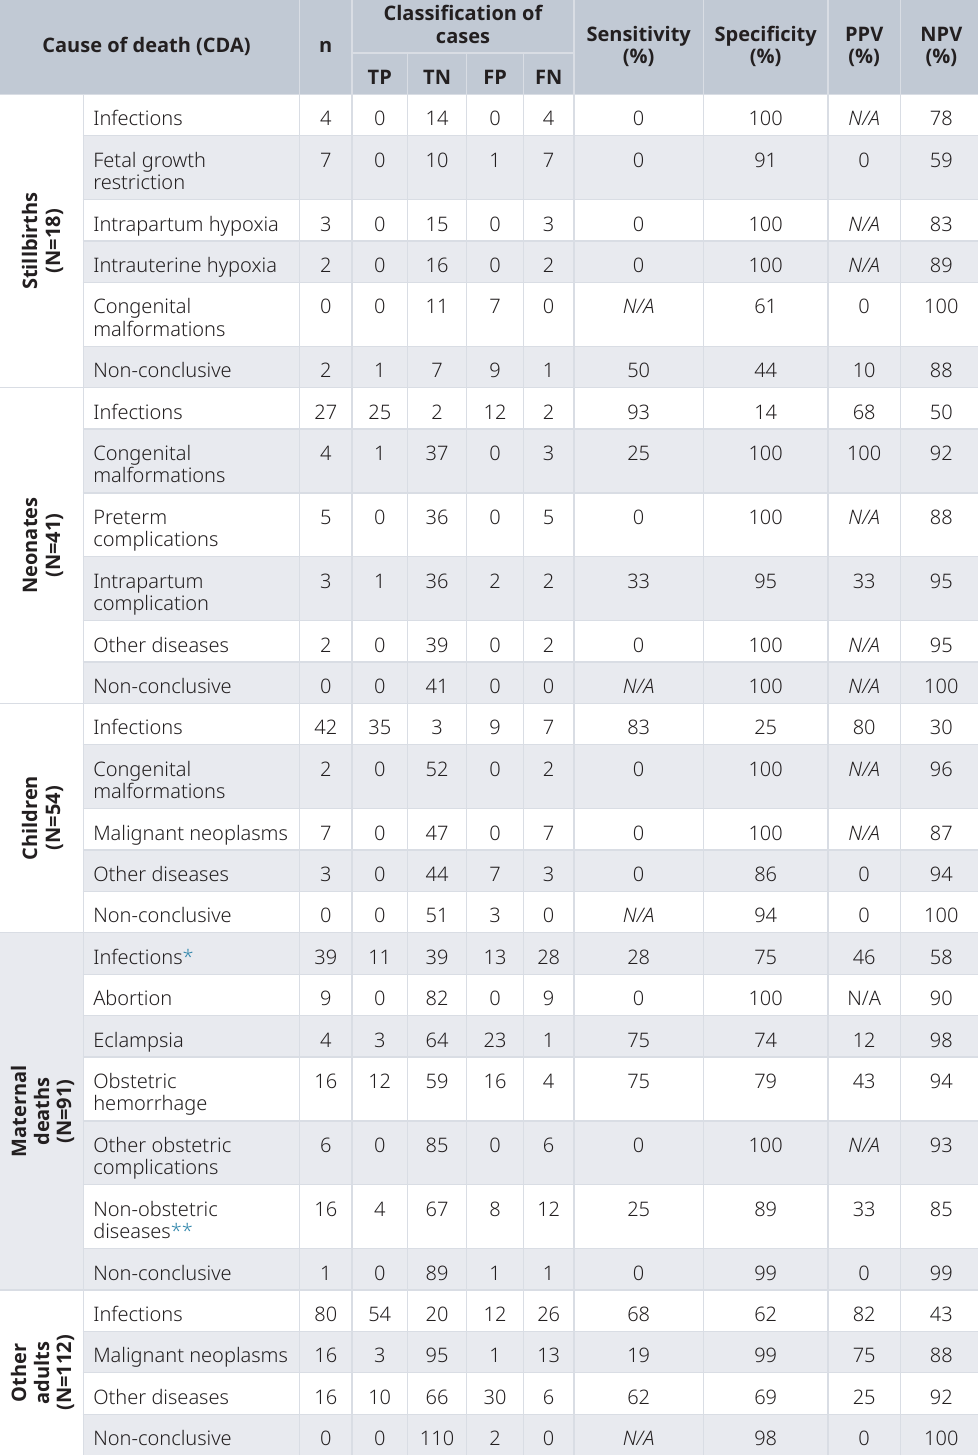
Table 1. Performance of the InterVA (Interpreting Verbal Autopsy) model compared to the complete diagnostic autopsy at individual-level prediction by study group and cause of death.